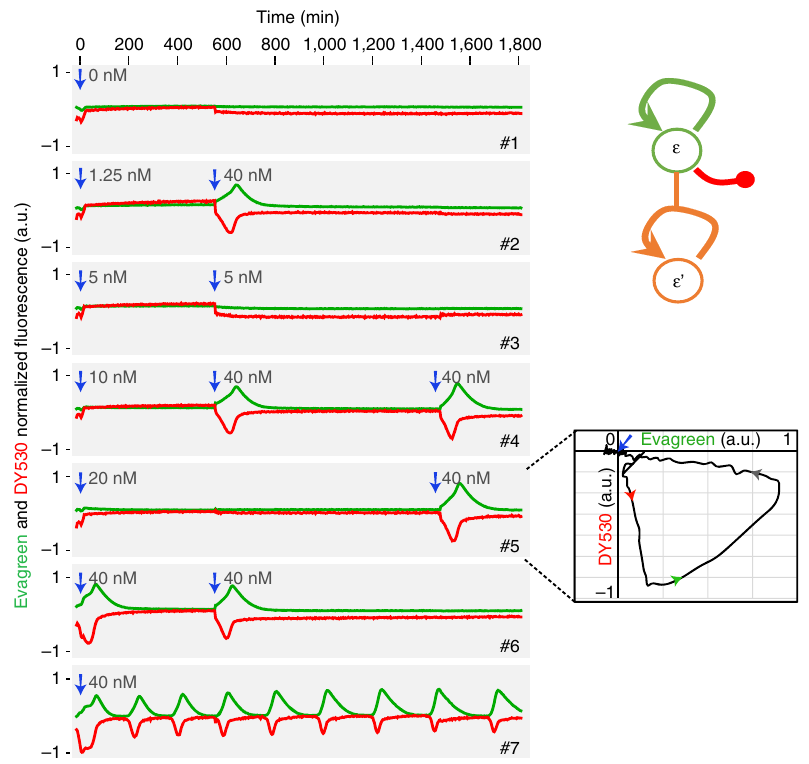
Figure 8 | Excitable molecular network. A positive feedback loop based on template e to e is connected to the cognate drain e . The sequences are designed in such a way that the amplification process is also linked to a negative feedback reaction driving the consumption of triggers e 3 . A series of replicates are initialized with different concentrations of trigger (from tubes #1 to #6: 0, 1.25, 5, 10, 20, 40nM e ) and only the tube #6 shows a strong excitable response. At t ¼ 545 and t ¼ 1,435min (blue arrows), triggers below (5nM) or above (40nM) the amplification threshold are injected in some of the tubes. Consistently, strong responses observed only above the threshold confirm the excitable character of the system. The inset displays the two-dimensional phase plot of the corresponding fluorescence traces, demonstrating the return to the 0 stable state after the excursion. The tube #7 contains only the template e to e (no drain). It exhibits an oscillatory behaviour since the 0 state is unstable and cannot trap the system at the end of a